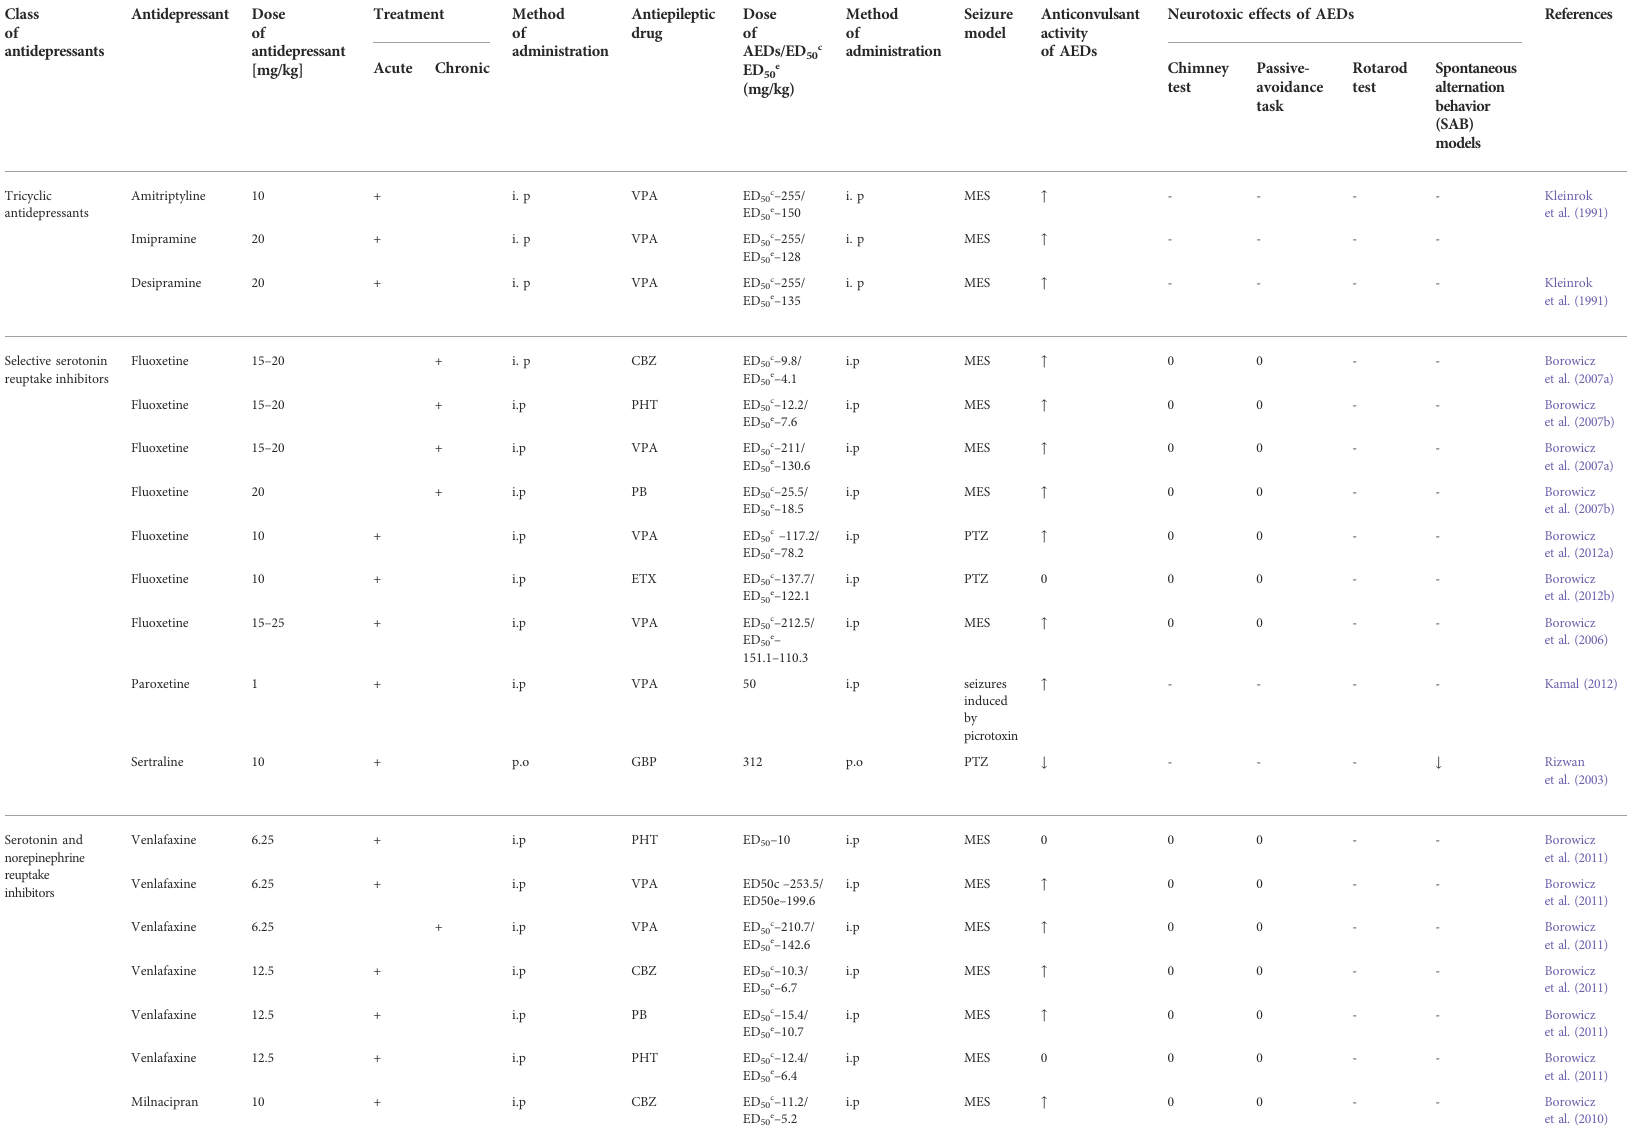
TABLE 2 Interactions between AEDs and antidepressant drugs in experimental seizure models. Class